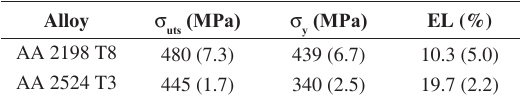
Table 2. Tensile test results. The standard desviation is in brackets.